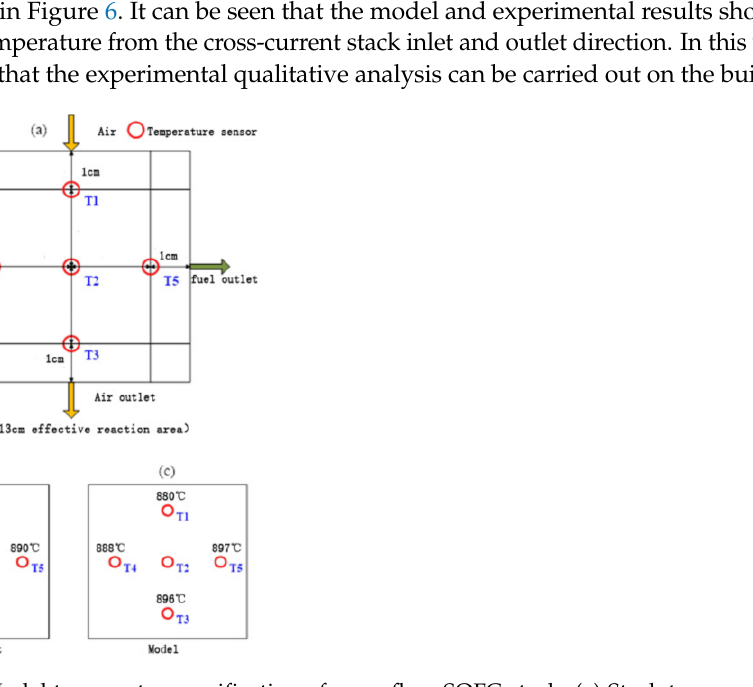
Figure 6. Model temperature verification of cross-flow SOFC stack: ( a ) Stack temperature sensor location; ( b ) Temperature distribution of SOFC stack in experiment; ( c ) Temperature distribution of SOFC stack in the